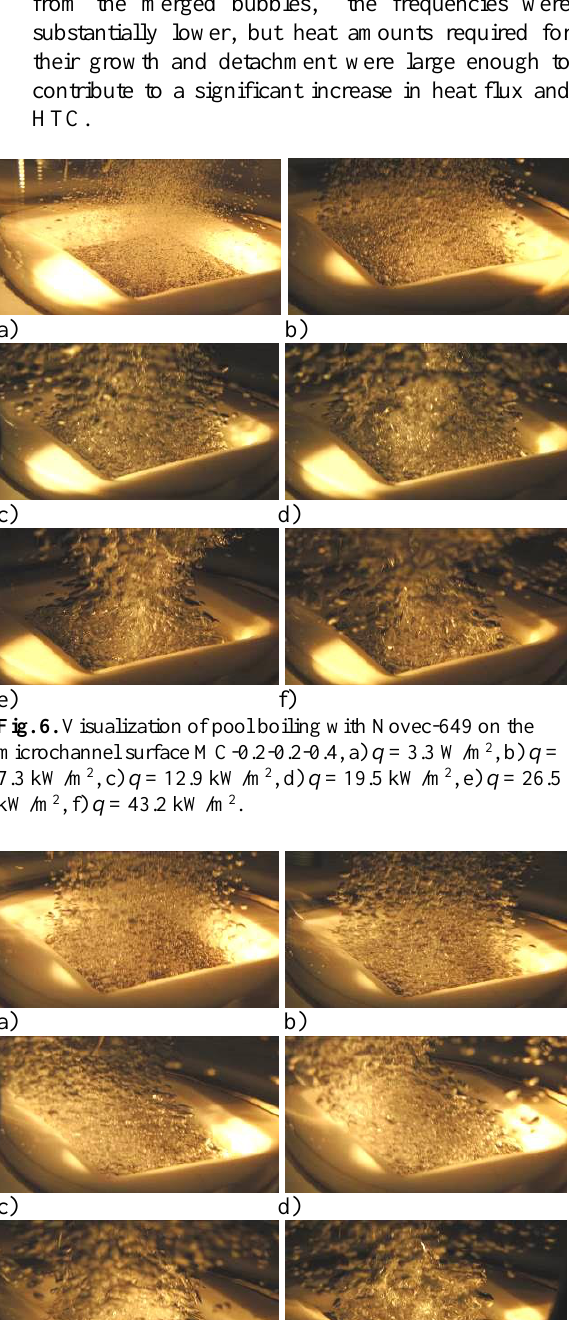
Fig. 7. Visualization observations of pool boiling of FC-72 on the microchannel surface MC-0.2-0.2-0.4, a) q = 5.0 W/m 2 , b) q = 8.8 kW/m 2 , c) q = 13.4 kW/m 2 , d) q = 19.1 kW/m 2 , e) q = 26.2 kW/m 2 , f) q = 43.5 kW/m 2 .